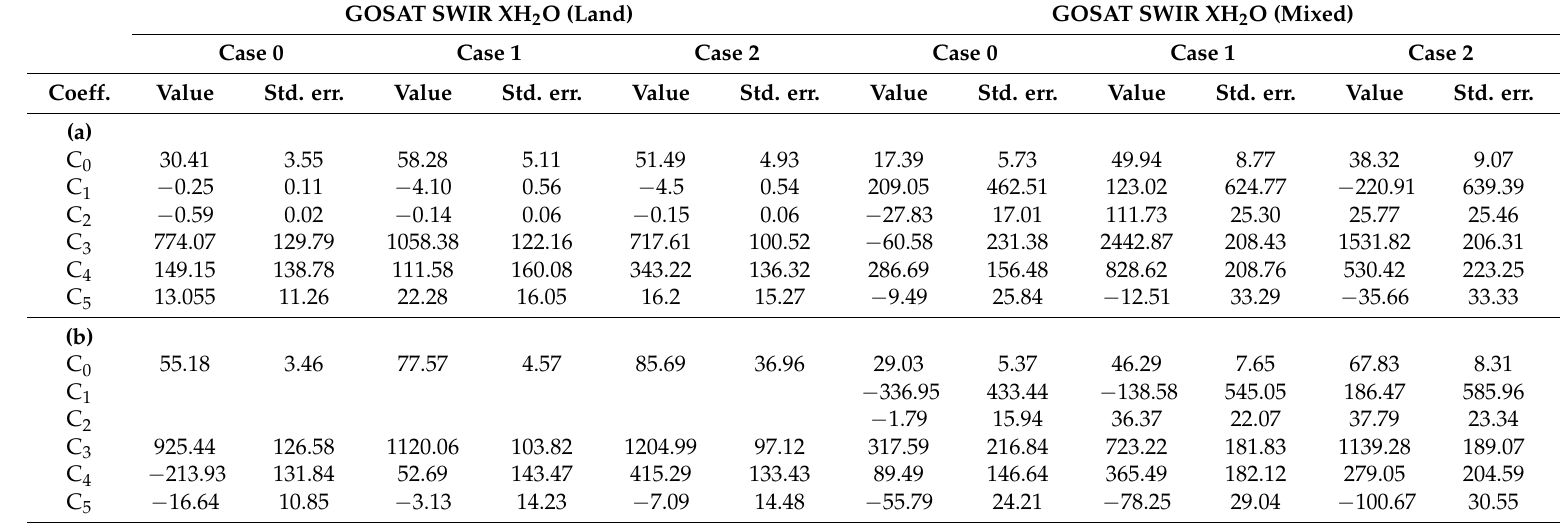
Table 1. Regression coefficients and their standard errors for the three colocation cases for the (a) bias-correction method (E) and (b) bias-correction method (A + E). The units of coefficients C 0 , C 1 , C 2 , (C 3 , C 4 ), and C 5 are (ppm), (ppm/hPa), (ppm/m), (ppm/units of albedo), and (ppm/air mass) for GOSAT